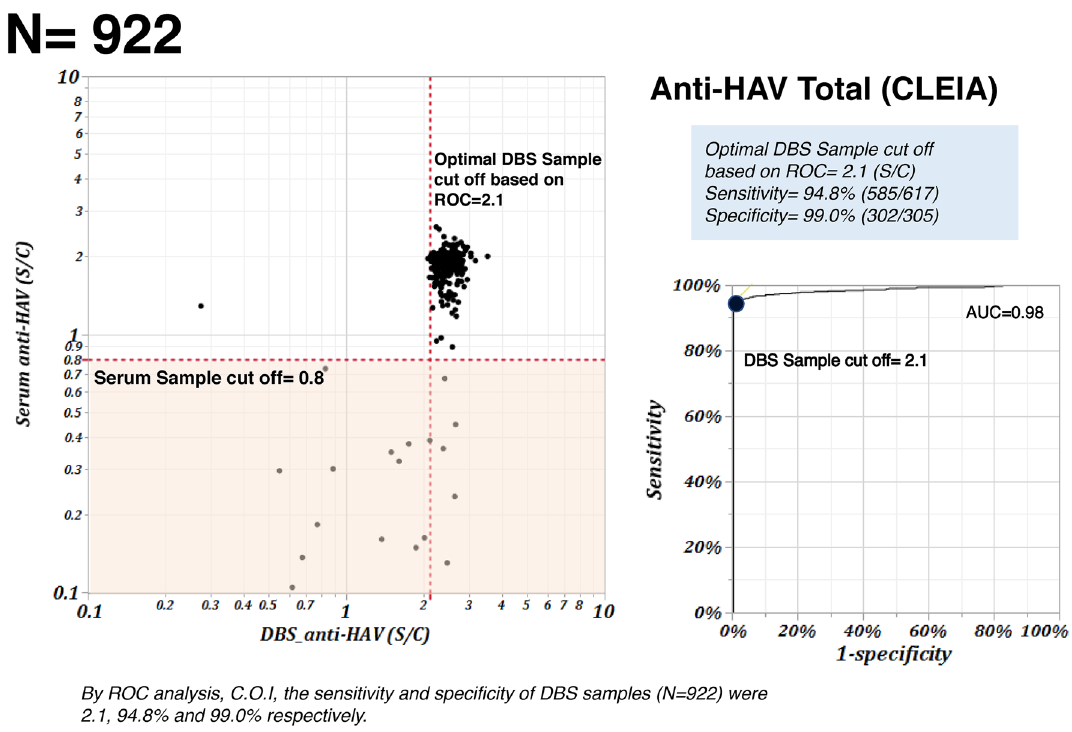
Figure 1. Scatter plot of Serum and DBS sample in Total-HAV Ab. This figure shows the agreement on the measure value of total anti-HAV between dried blood spot sample-driven samples and whole blood samples from 922 randomly selected participants in Cambodia. The scattered plot shows the cut-off value for the detection of total anti-HAV from DBS against the whole blood samples. The area under curve (AUC) was